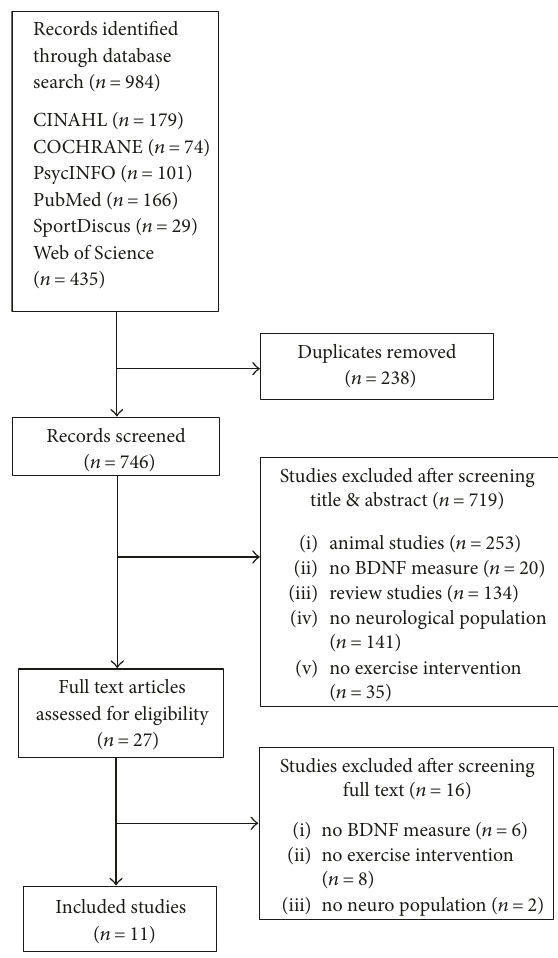
Figure 2: A fl ow diagram of the systematic review literature